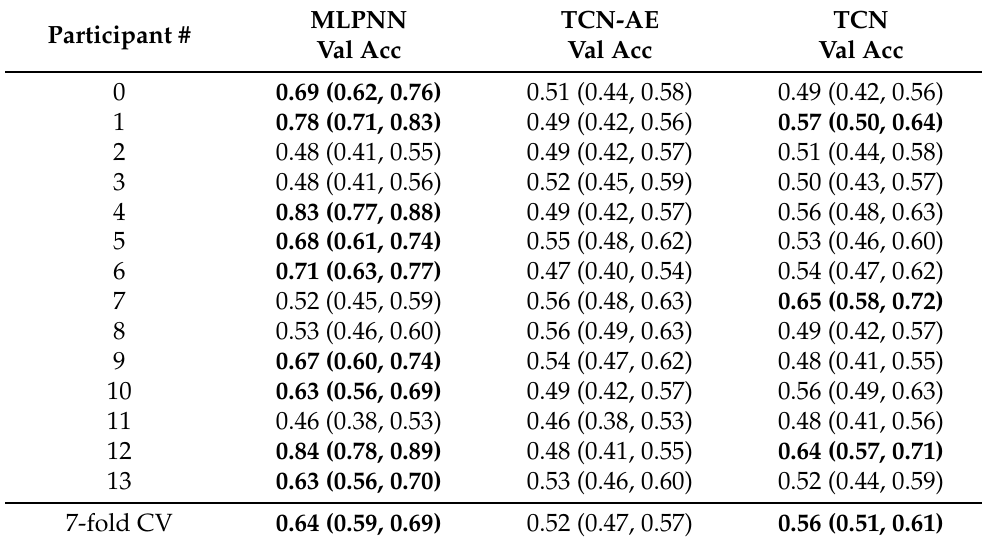
Table 1. Vigilance decrement classification model performance results for each model type. Par- ticipant validation accuracies and the 7-fold CV accuracy are provided for each model, with 95% confidence intervals provided in parentheses. For both participant accuracies and the 7-fold CV results across all participants, Bold signifies statistical significance of accuracy over random chance (defined as 50% for this binary classification task) as evidenced by the 95% confidence